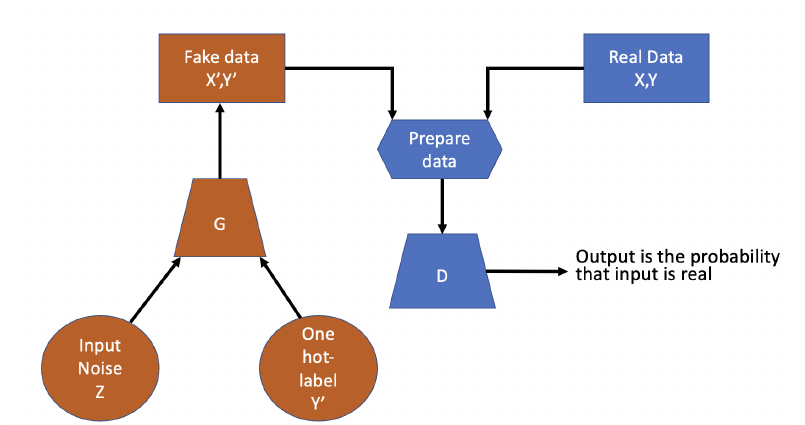
Figure 2. Conditional GAN